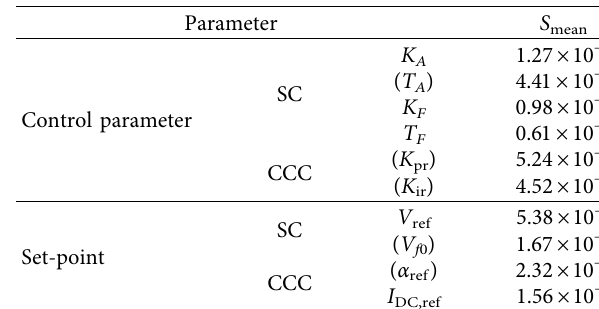
Table 2: Calculation of evaluation indices for δ